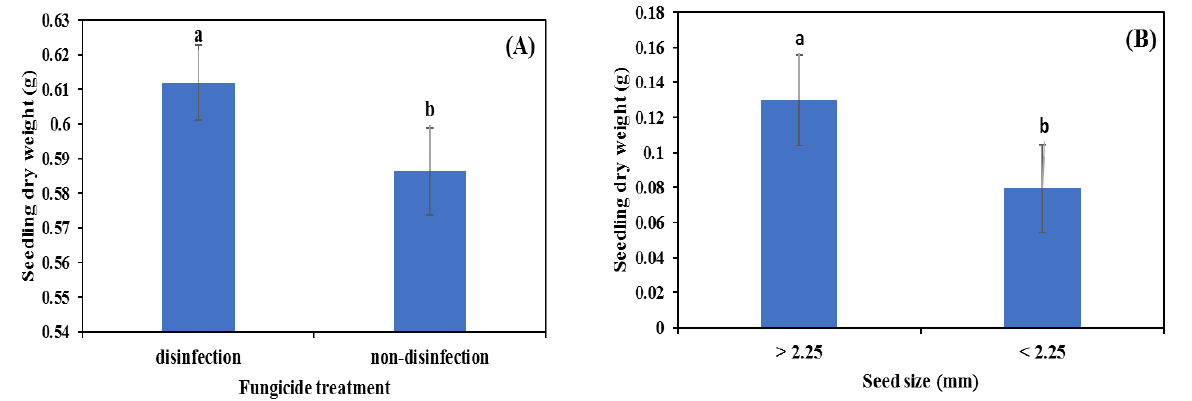
Figure 4. Effect of seed disinfection ( A ), seed size ( B ) on dry weight of seedlings. The columns ’ letters indicate the differences between the different treatments ( p < 0.05) using the LSD test.